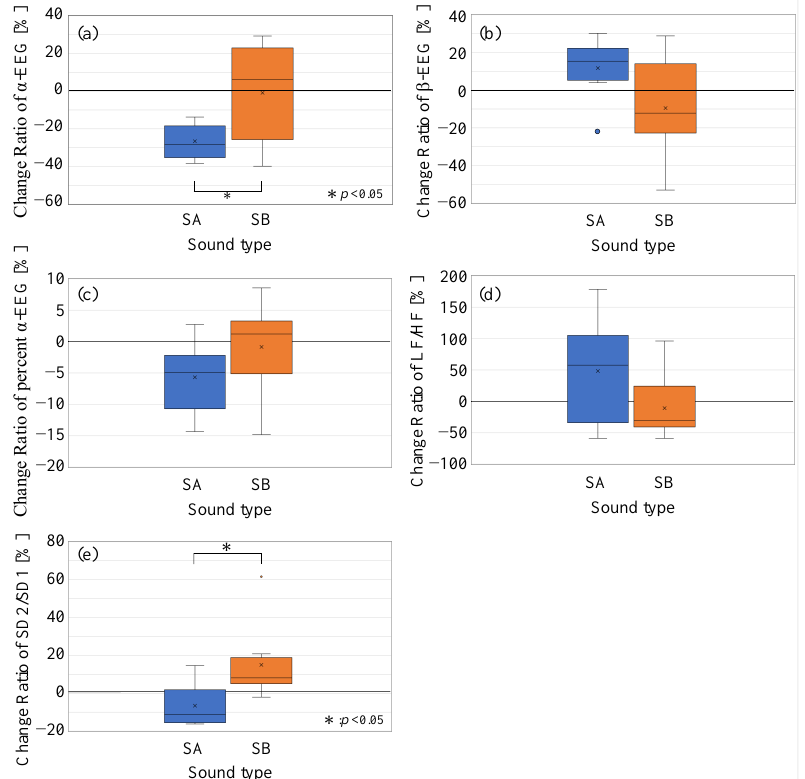
Figure 8. Experimental results of the averaged values and their SDs of the biological responses of ( a ) α-EEG, ( b ) β-EEG, ( c ) percent α-EEG, ( d ) LF/HF, and ( e ) SD2/SD1, respectively. In these results, each of the biological results in the conditions of SA (white noise) and SB (murmuring river sound)